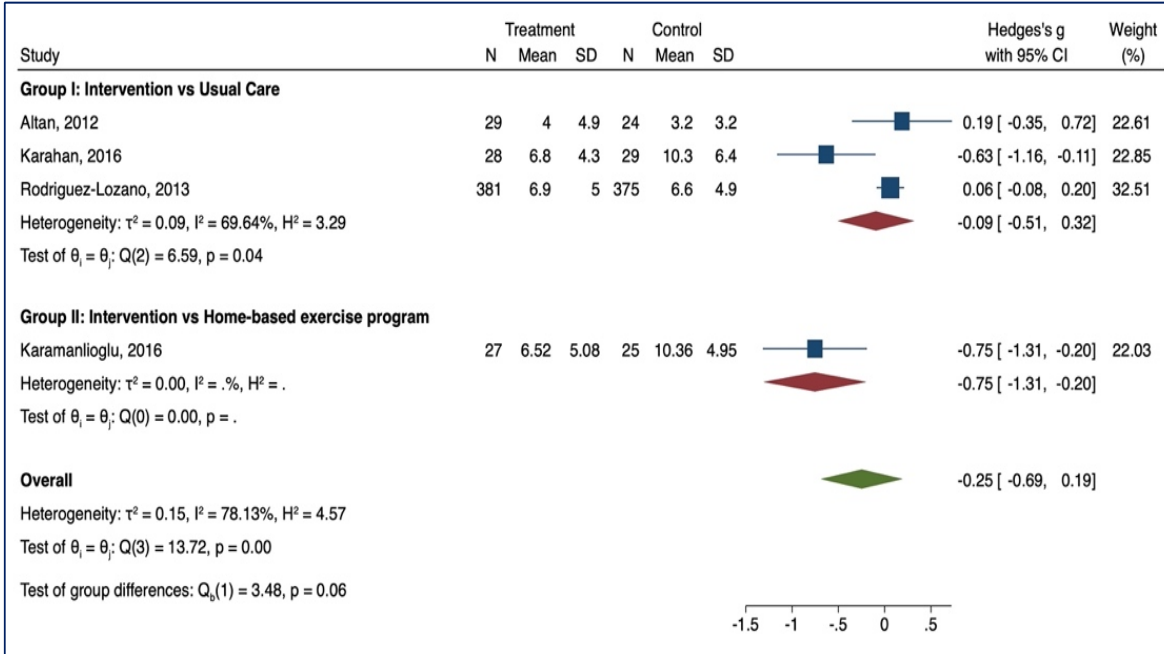
Figure 7. ASQoL—Forest